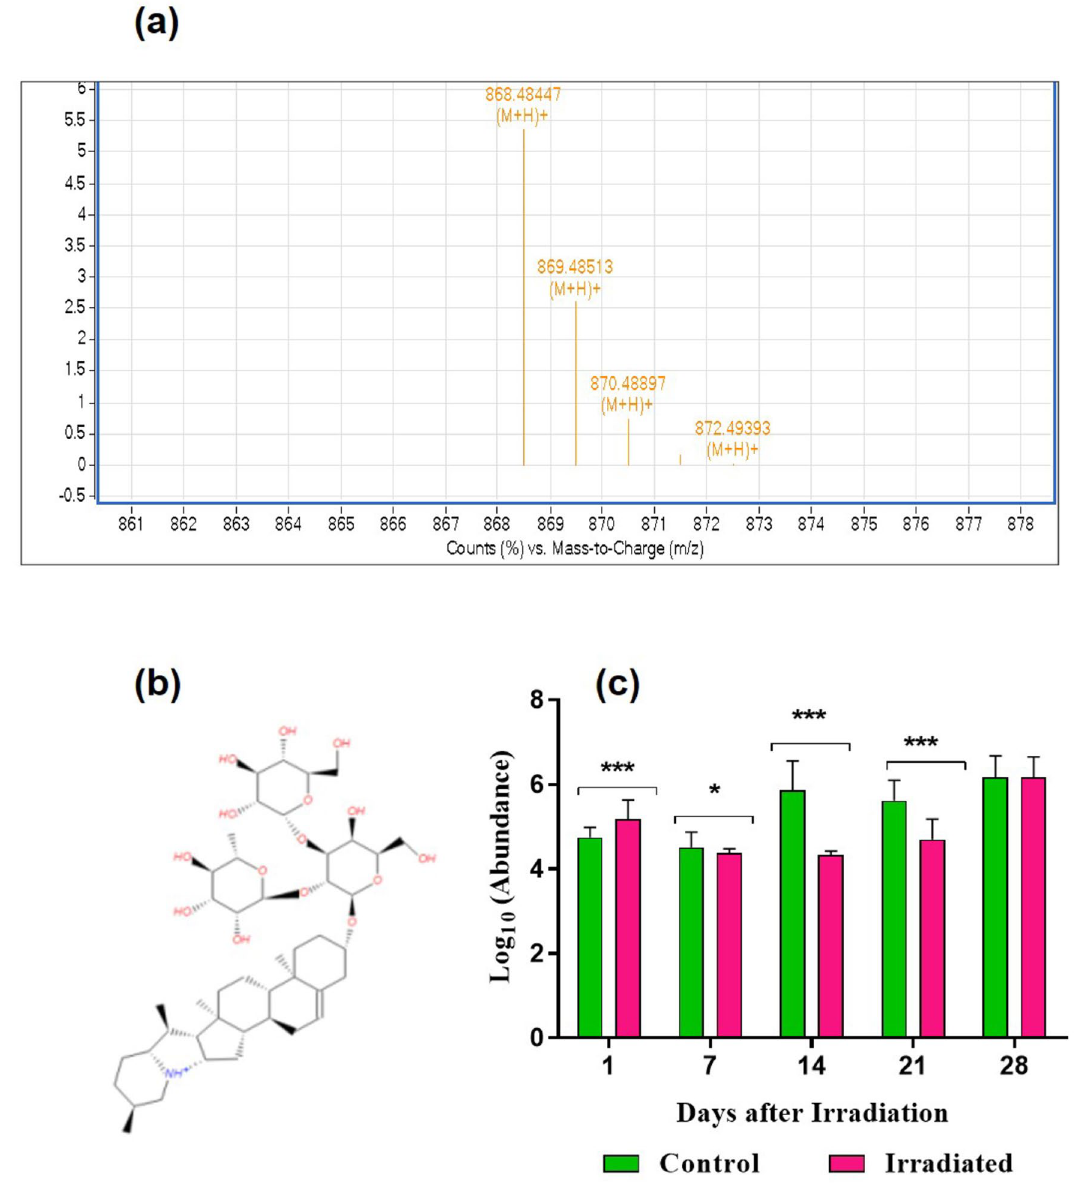
peak chromatogram of α-solanine, ( b ) structure and ( c ) Abundance value (log10) obtained from the control and laser-irradiated group. Statistically significant changes in metabolite intensity between the control and laser- irradiated groups are represented as *** p < 0.001 and * p < 0.05 (n =